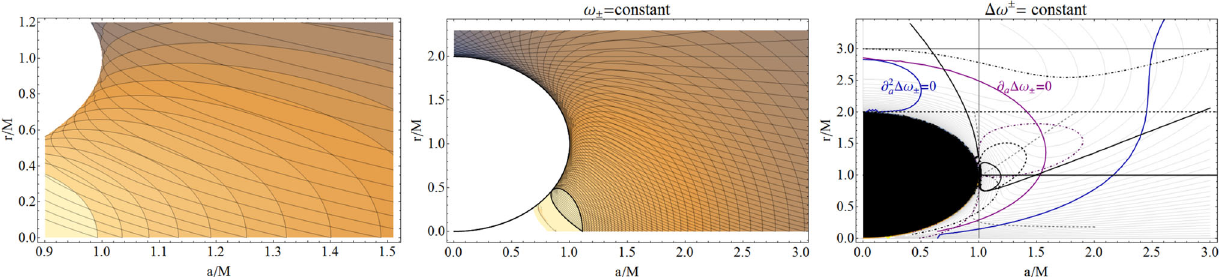
Fig. 6 Left and center panels: curves ω ± = constant in different geometries with spacetime dimensionless spin a / M . Horizons are black thick lines. Right panel: curves (cid:2) − ω ≡ ω + − ω − = constant and notable radii – see Fig. 5